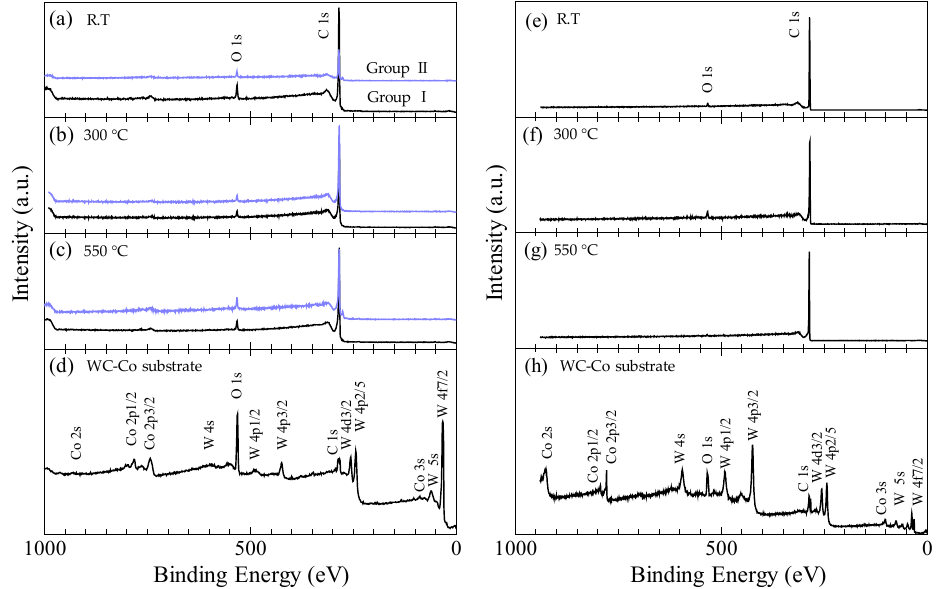
Figure 2. Soft X-ray photoemission spectroscopic (SXPES) survey ( a – d ), and hard X-ray photoemission spectroscopic (HAXPES) survey ( e – h ), of Group I ultrananocrystalline. diamond/amorphous carbon (UNCD/a-C) films deposited at substrate temperature of room temperature (R.T.), 300 °C, and 550 °C, and WC-Co substrate.